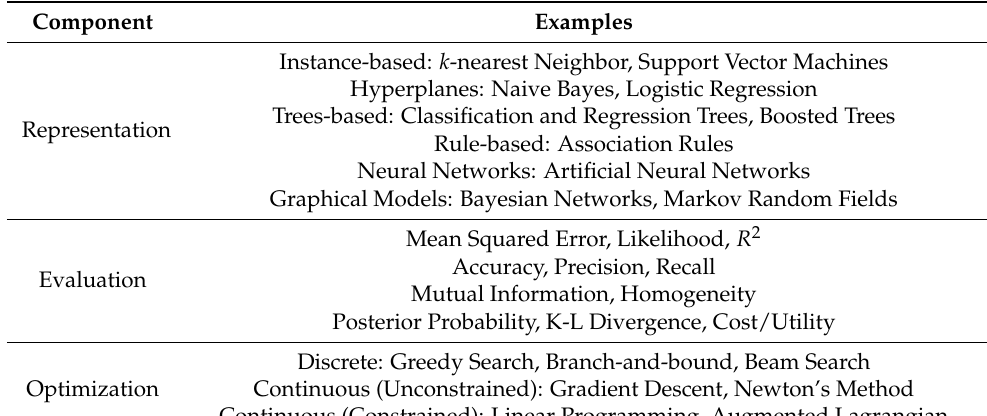
Table 1. Examples of the three components of learning algorithm (Original structure from